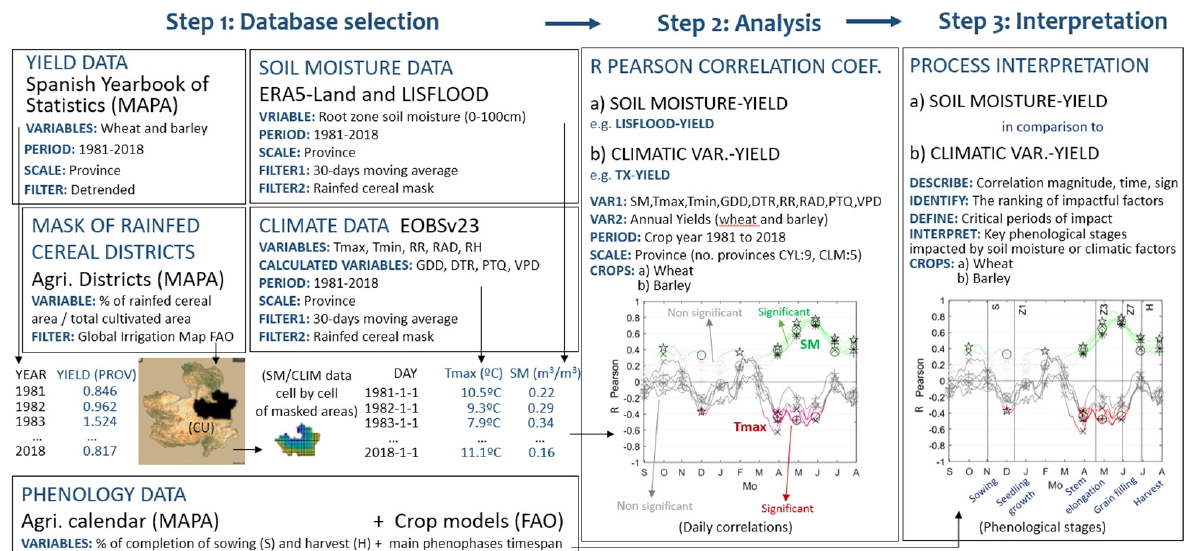
Figure 3. Workflow of the study depicts the tasks conducted to select data, process the temporal correlations, and identify the impact of each variable on the evolution of wheat and barley during the growing